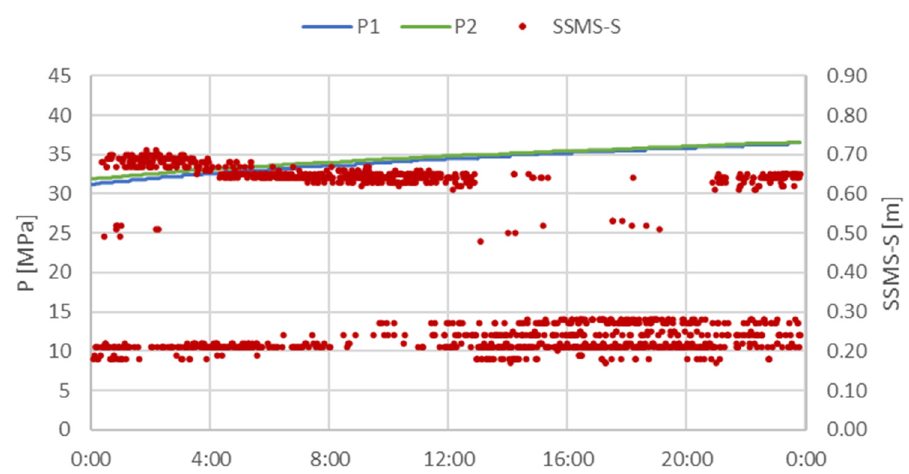
Figure 12. Roof support No. 59 pressure and tip-to face distance (14 February 2021).